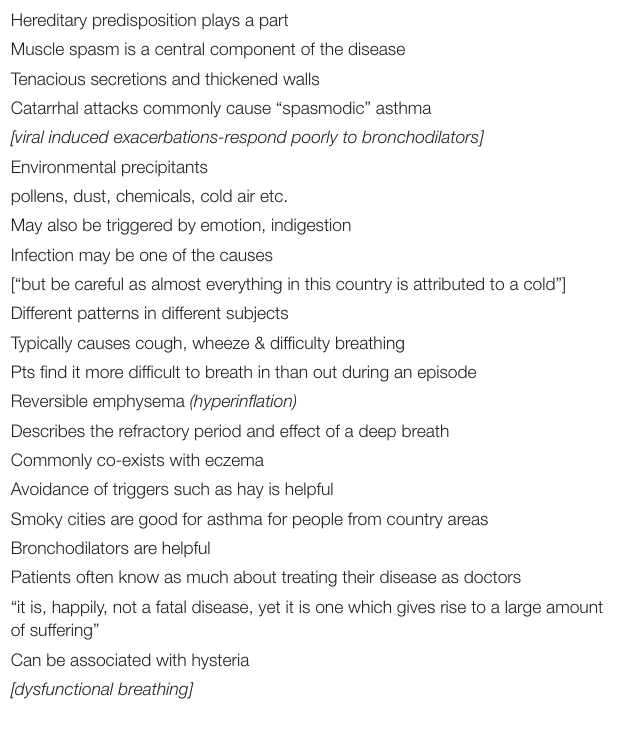
TABLE 1 | Summary of Williams, 1874